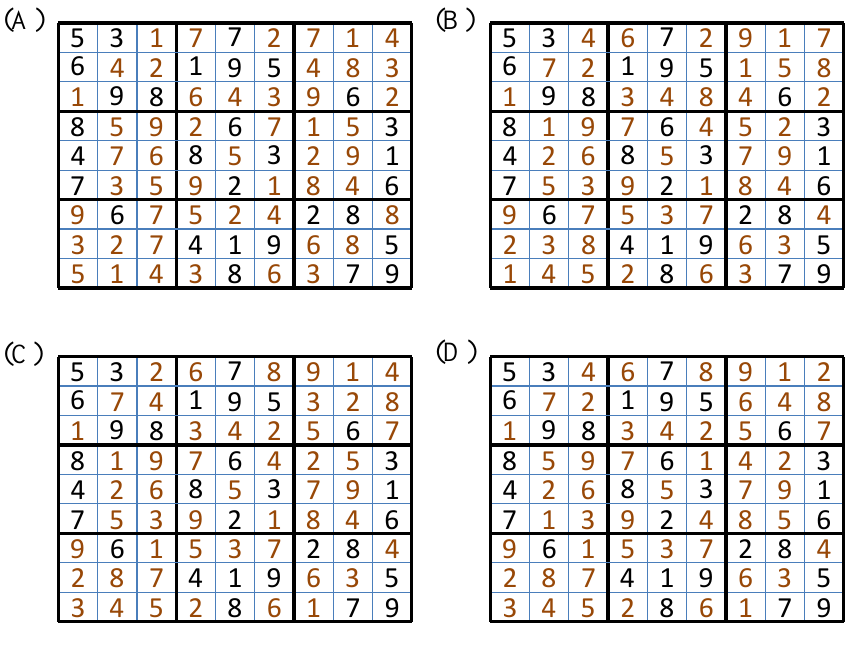
Fig. 4. Sudoku puzzle: evolution of the DREAM ( D ) sampled parameter space to the posterior distribution: (A) typical starting solution, (B) intermediate solution, (C) nearly final solution, and (D) final